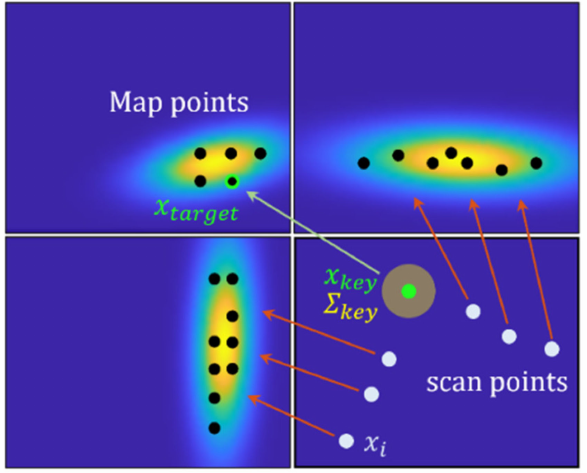
Figure 4. Correspondence between scan points and map